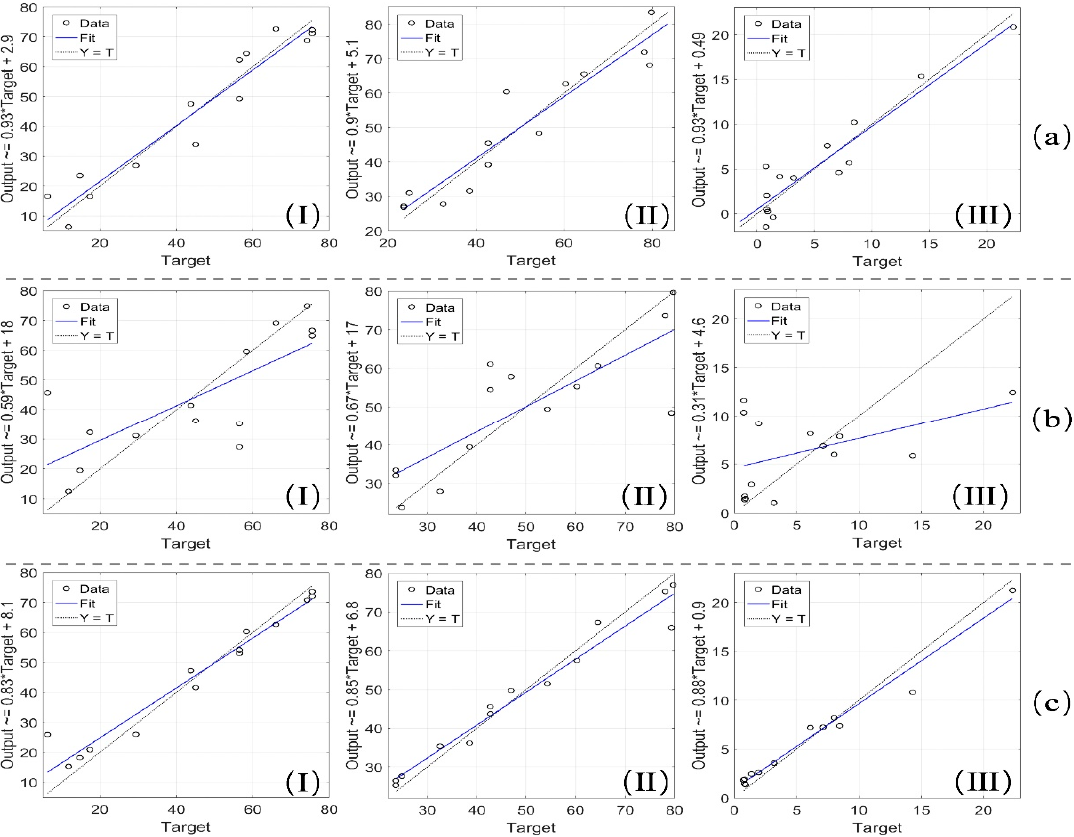
Figure 13. Regression between predicted and true values of ( a ) MLR, ( b ) PLSR, and ( c ) SVM models, (I) sand, (II) silt, and (III) clay content using 6SV atmospheric correction surface reflectance data.